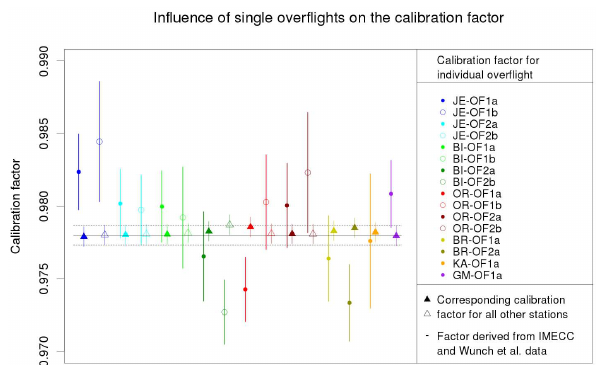
Fig. 8. Influence of the individual overflights of the IMECC sites on the calibration factor. For this study, the calibration factor for each individual overflight and the artificial calibration point in the origin were derived (full and empty dots). An additional calibration factor was calculated for the corresponding remaining overflights and the artificial calibration point in the origin (full and empty triangles). The error bars of the overflights JE-OF1a, JE-OF1b, BI-OF2b, OR- OF1a and BR-OF2a do not overlap with the respective calibration factors derived from the overflights over the corresponding remain- ing